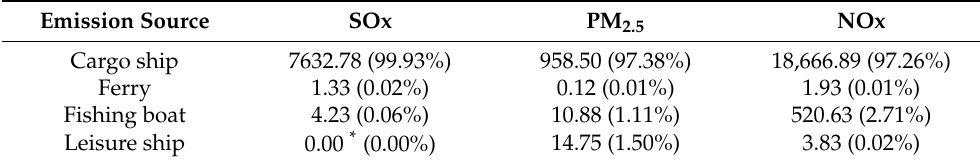
Table 4. Air pollutant emissions and proportion by type of ship in Busan in 2016 (unit: ton/year). Emission Source